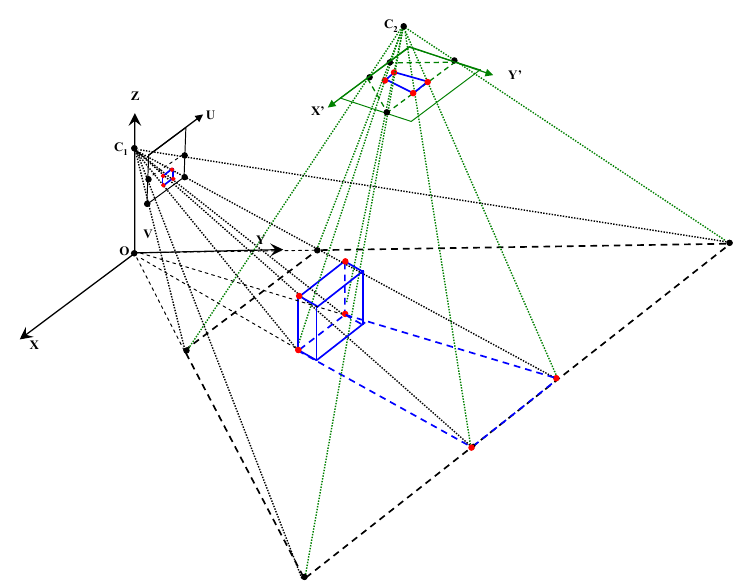
Figure 9. Spatial distribution properties of ground and object regions in perspective mapping and inverse perspective mapping.